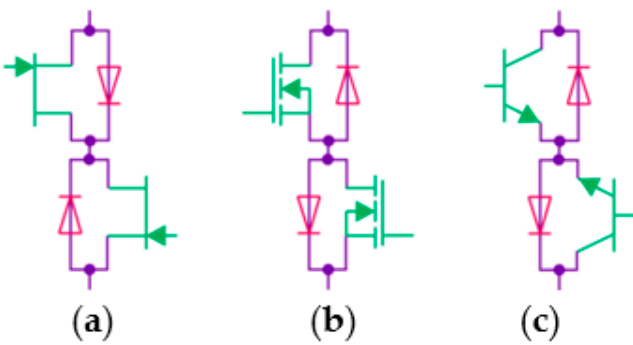
Figure 2. Silicon carbide (SiC) two-direction switch topologies: ( a ) JFET with common drain configuration; ( b ) MOSFET with common source configuration; ( c ) BJT with common emitter.